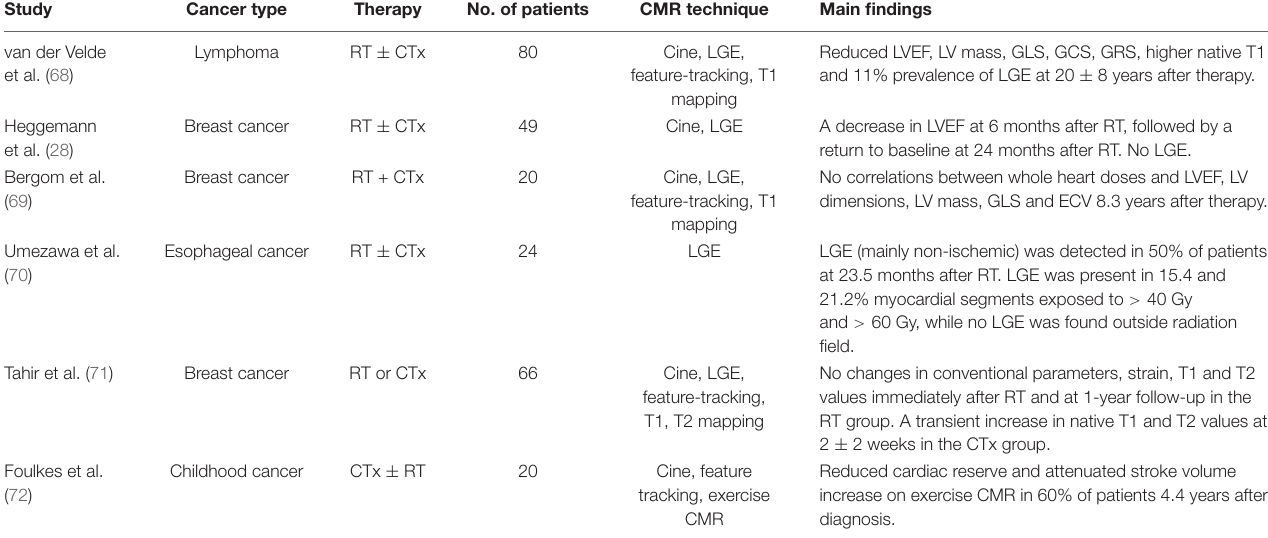
TABLE 2 | CMR studies to detect RT-induced